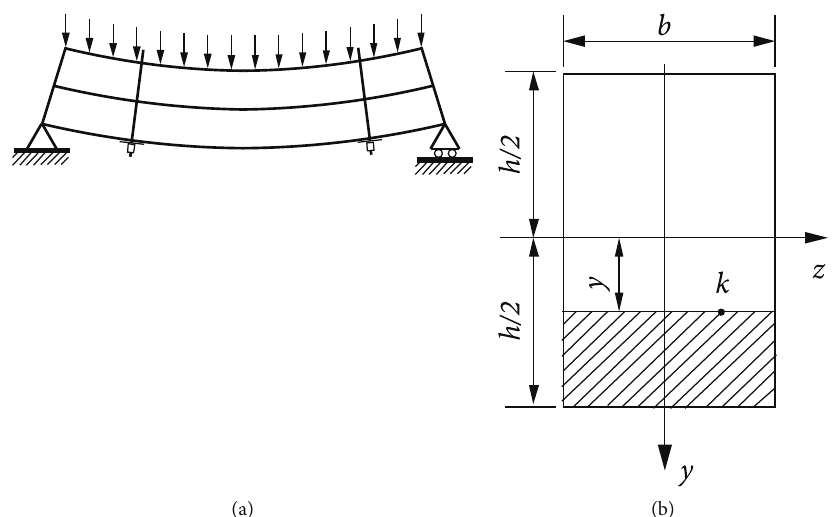
Figure 4: Schematic diagram of the shear force carried by the anchor when the rock beam bends. (a) With anchor. (b) Shear stress at any point k on the cross-section at a distance y from the neutral axis during rock